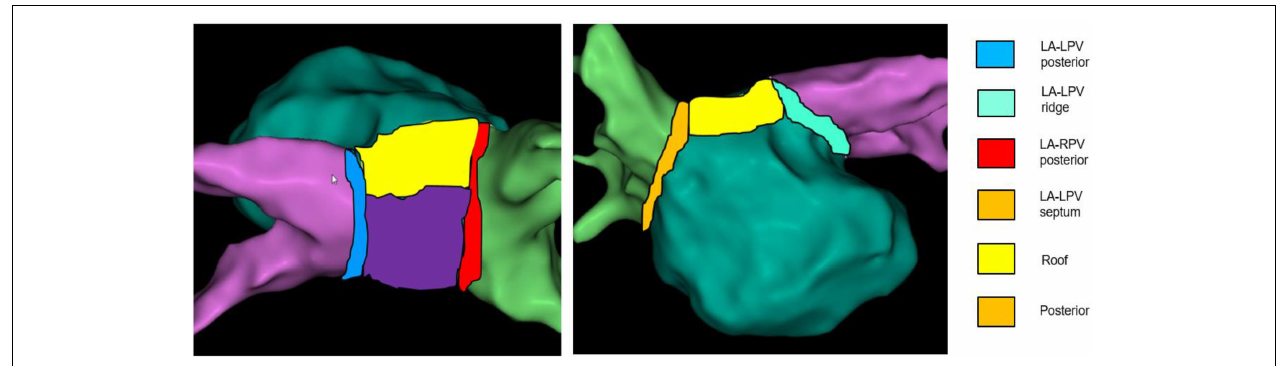
FIGURE 2 | Regionalization of the left atrium. Schematic of six regions of pulmonary vein antrum sampled for voltage comparisons is provided.